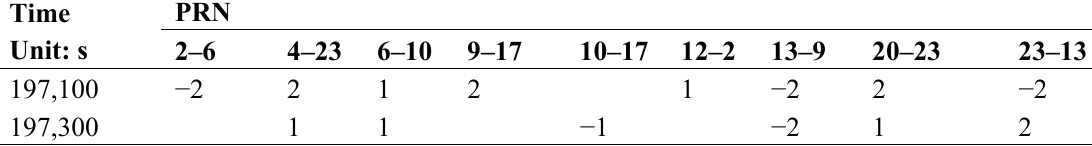
Table 7. Detected cycle slips (proposed